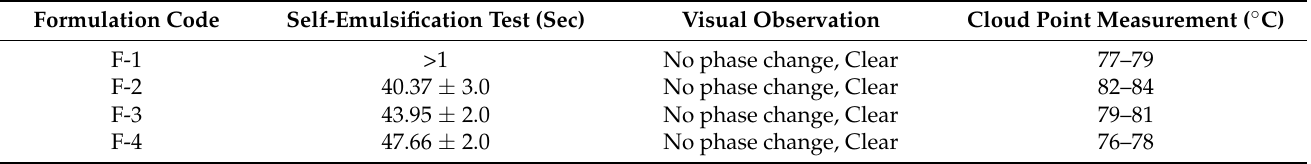
Table 4. Emulsification and cloud point measurements of Cefixime-loaded SEDDS formulations. Formulation Code